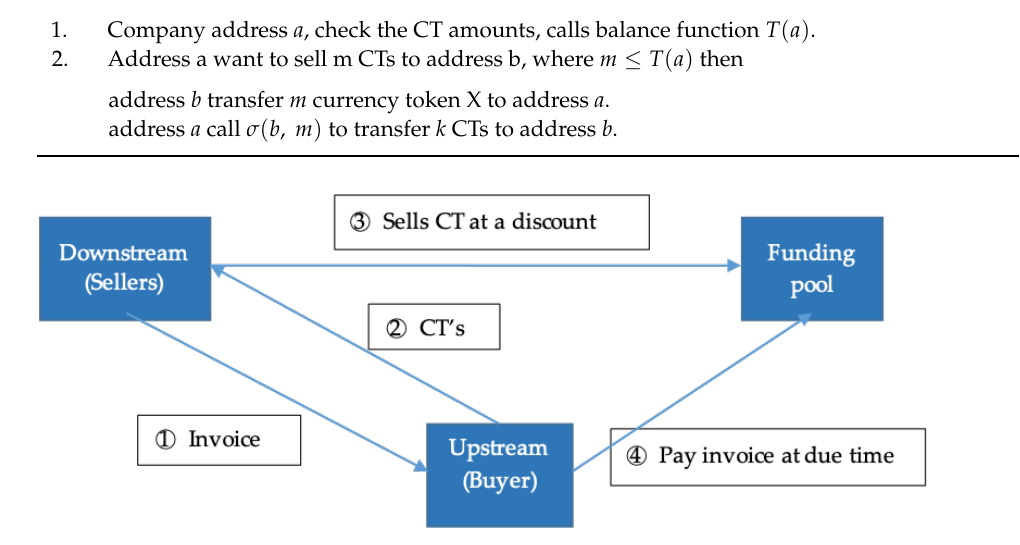
Figure 7. CT as the accounts receivable.